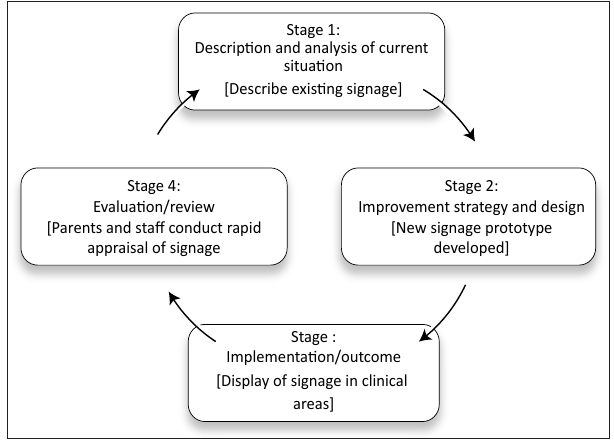
FIGURE 1: Action research process followed to develop family-friendly